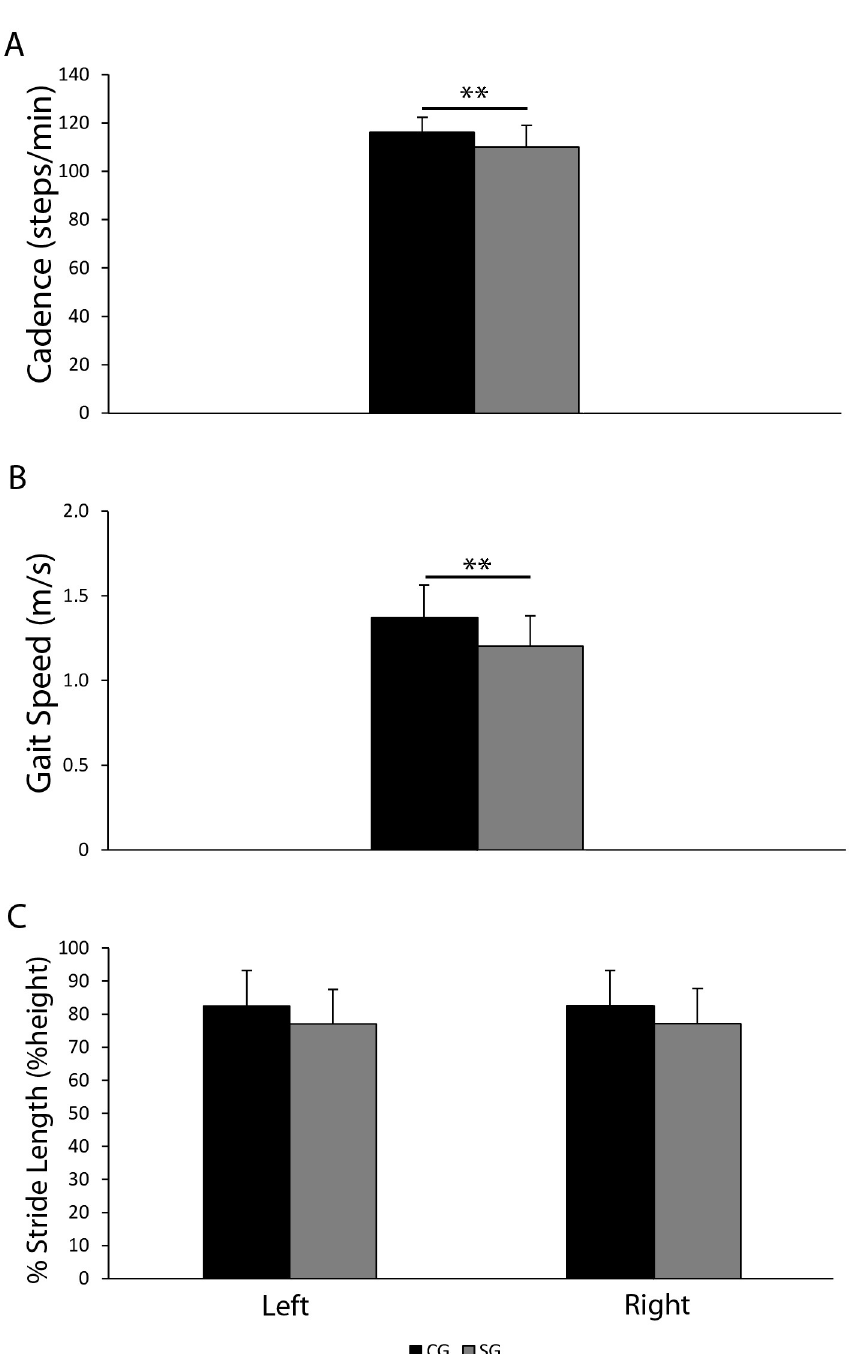
Fig 2. Cadence (panel A), gait speed (panel B) and percentage of stride length (% Stride Length, panel C) for healthy controls (CG, n = 24) and schizophrenia group (SG, n = 27). T-tests were performed between CG and SG for cadence and gait speed, one-way ANOVA for comparisons between left and right percentage of stride length between CG and SG. Data were considered statistically significant if p -Value was less than 0.05. �� p < 0.01. https://doi.org/10.1371/journal.pone.0245661.g002 with ETD and LTD [ETD: M = 110.1, SD = 8.3; LTD: M = 106.1, SD = 8; CG: M = 116.2, SD = 6.2; ETD vs CG t(34) = 2.49, p < .01; LTD vs CG t(31) = 3.85, p < .01], mirroring what